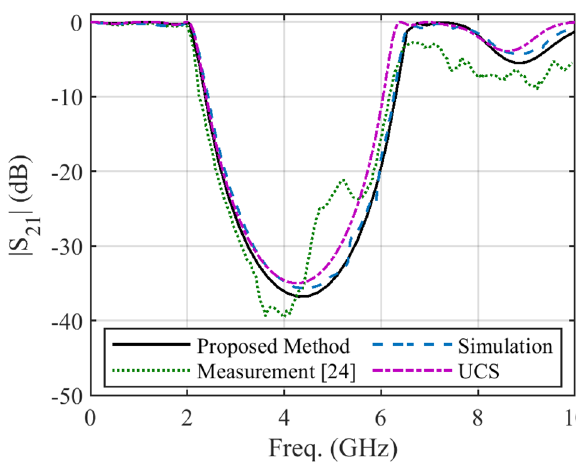
Figure 5. The frequency response of the non-uniform stop-band